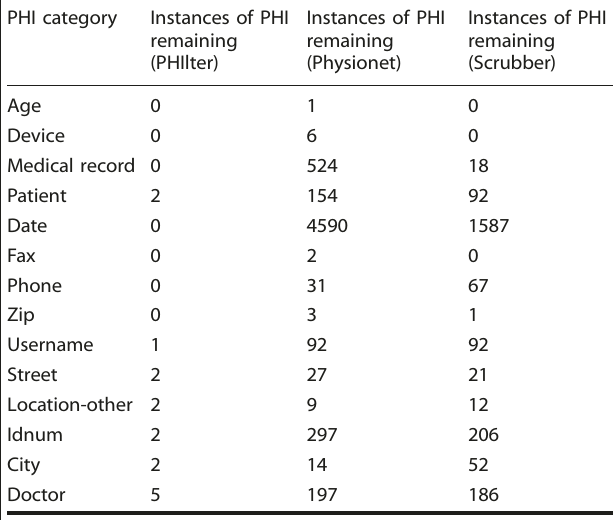
Table 3. Remaining PHI analysis by tool, I2B2